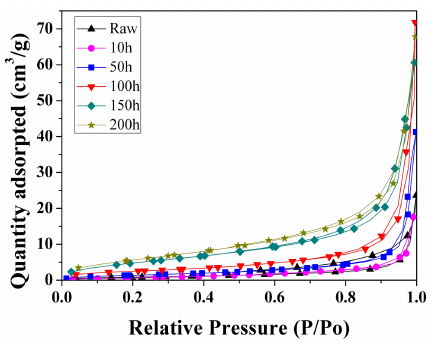
Figure 6. Nitrogen adsorption/desorption isotherms of the raw sample and spent samples extracted by sub-critical water at 350 ◦ C for different times.